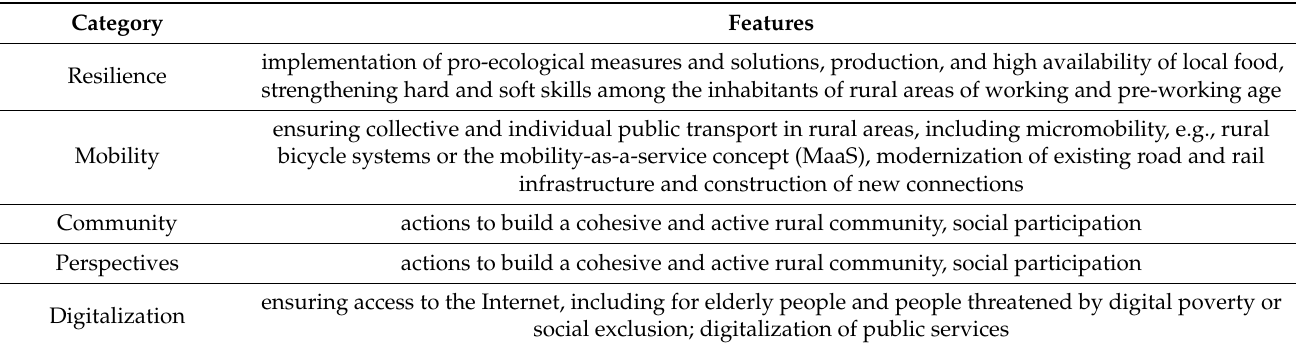
Table 1. Model of smart villages (own study, based on